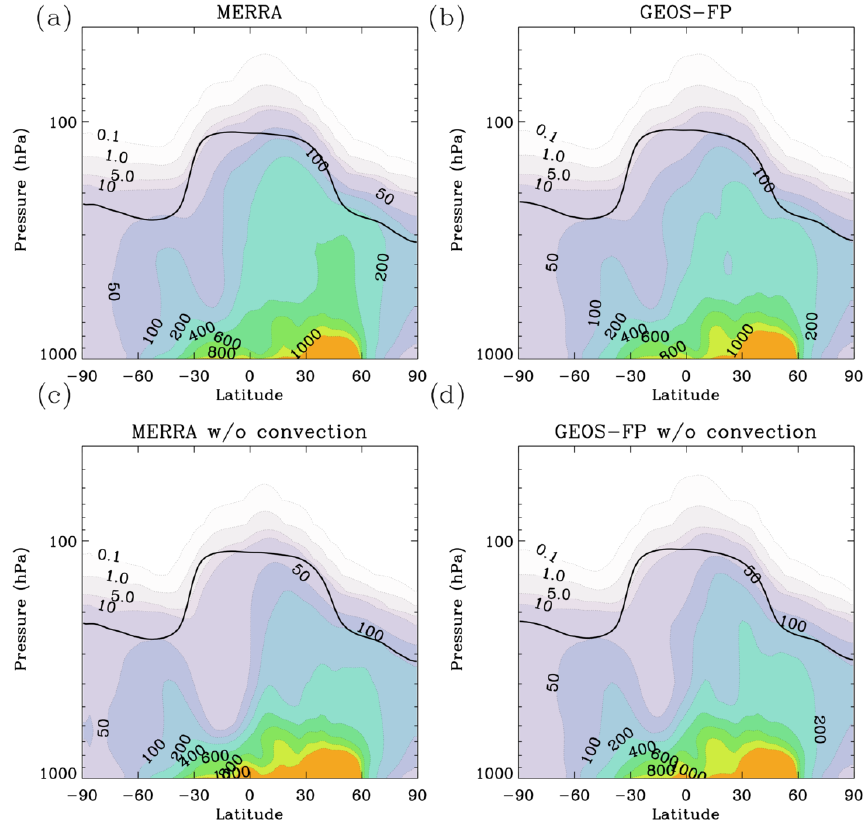
Figure 13. Latitude–pressure cross-sections of zonal mean 222 Rn concentrations averaged over June–July–August (mBq/SCM) as simulated by the GEOS-Chem model driven by (a) MERRA (A-1), (b) GEOS-FP (B-1), (c) MERRA without convection (A1-nc), and (d) GEOS-FP without convection (B1-nc). Bold black lines denote the zonal mean tropopause height (hPa) in the corresponding meteorological dataset.